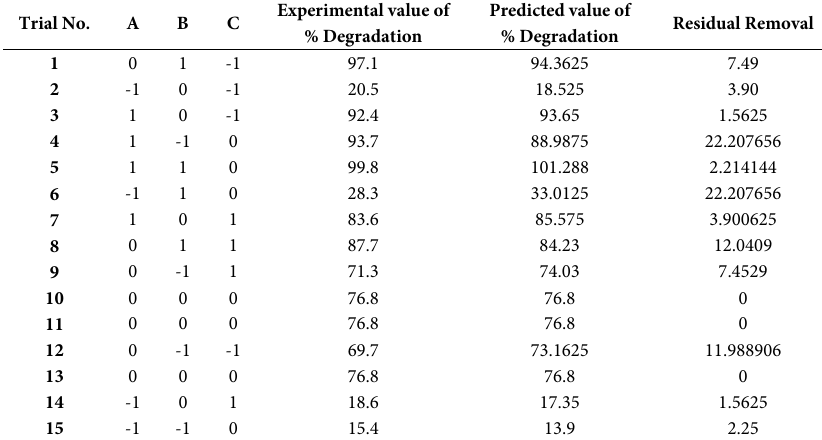
Table 4: BBD matrix of variables along with actual, fits, and residual values for adsorption of EB on ZrO 2 Trial No.